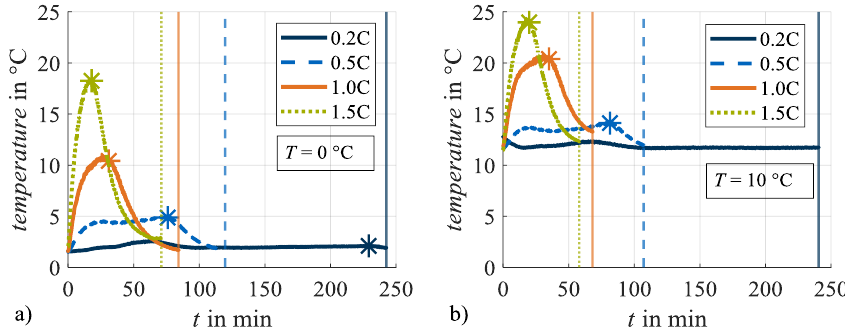
Figure 3. Evolution of cell temperature during charging at different charging rates at ( a ) 0 °C and ( b ) 10 °C. The asterisks mark the end of the constant current phase, the vertical lines the end of the constant voltage phase.